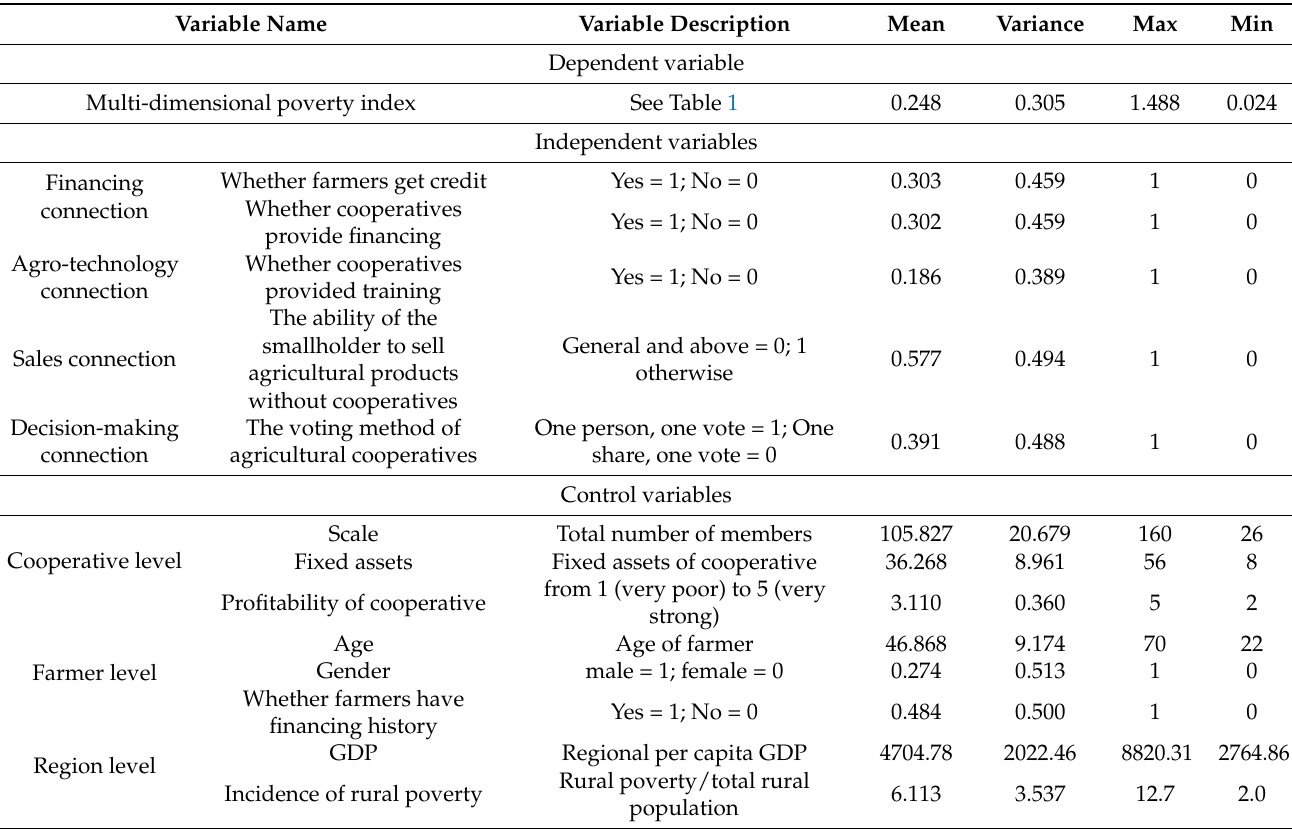
Table 2. Descriptive